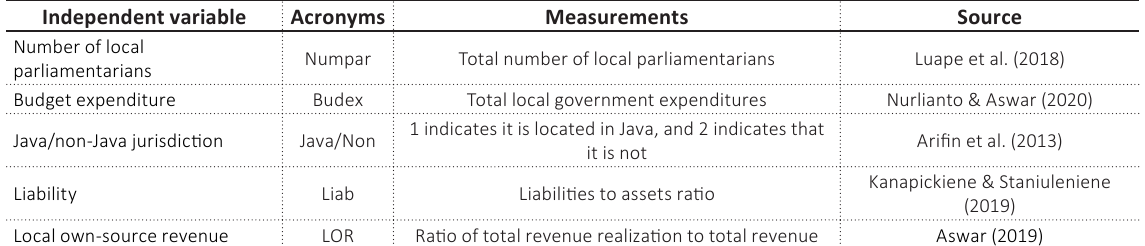
Table 2. Variable